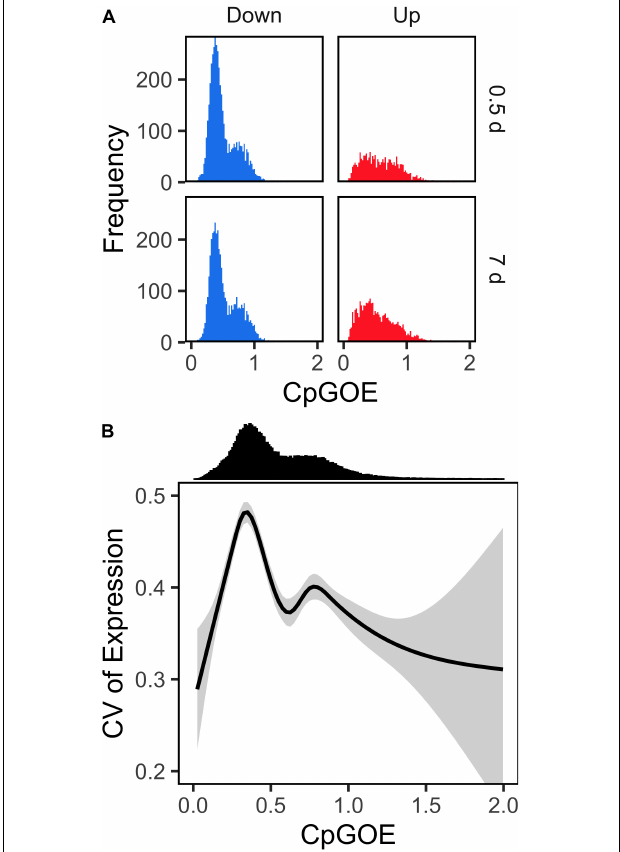
FIGURE 4 | Transcripts downregulated by Limacina helicina antarctica in response to future p CO 2 extremes show enriched signatures of gene body methylation. (A) CpGOE histograms are plotted for transcripts exhibiting significant downregulation (blue) or upregulation (red) under 918 µ atm p CO 2 . Bin widths = 0.02 CpGOE. (B) Mean CV of expression is plotted across CpGOE. Shaded regions depict ± 95%